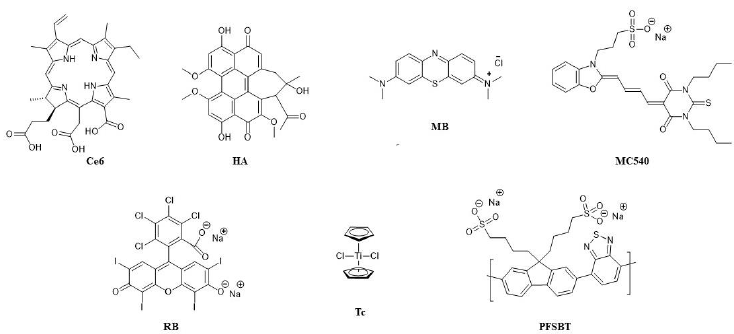
Figure 4. Structures of the PSs used for combining in UCNPs and their abbreviations.